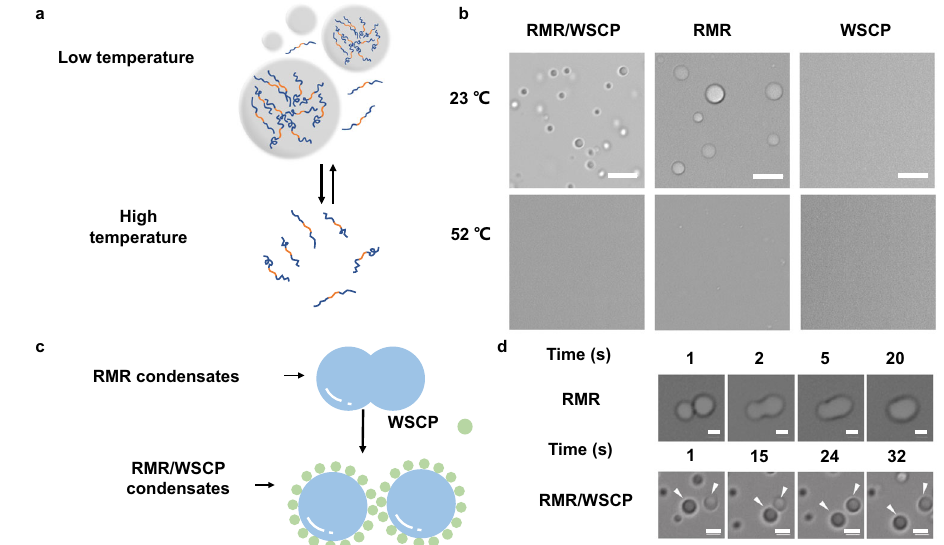
Fig. 3 Temperature-dependent liquid-liquid phase separation of RMR in the presence and absence of WSCP. a Schematic showing temperature- dependent phase separation of RMR. b Representative images showing temperature-dependent phase separation of RMR in the presence and absence of WSCP. Scale bars: 5 μ m. Images representative of n = 3. c Schematic showing stabilization of RMR condensates by WSCP. Two RMR condensates are coalescing into a bigger one in the absence of WSCP, while remaining separate upon decoration with WSCP. Confocal imaging analysis revealed the presence of WSCP both on the surfaces and inside of the RMR condensates (Supplementary Fig. 4). The cartoons of WSCP inside the condensates are omitted for clarity. d Representative images showing RMR condensates in the absence and presence of WSCP at 23 °C with the passage of time. Scale bars: 1 μ